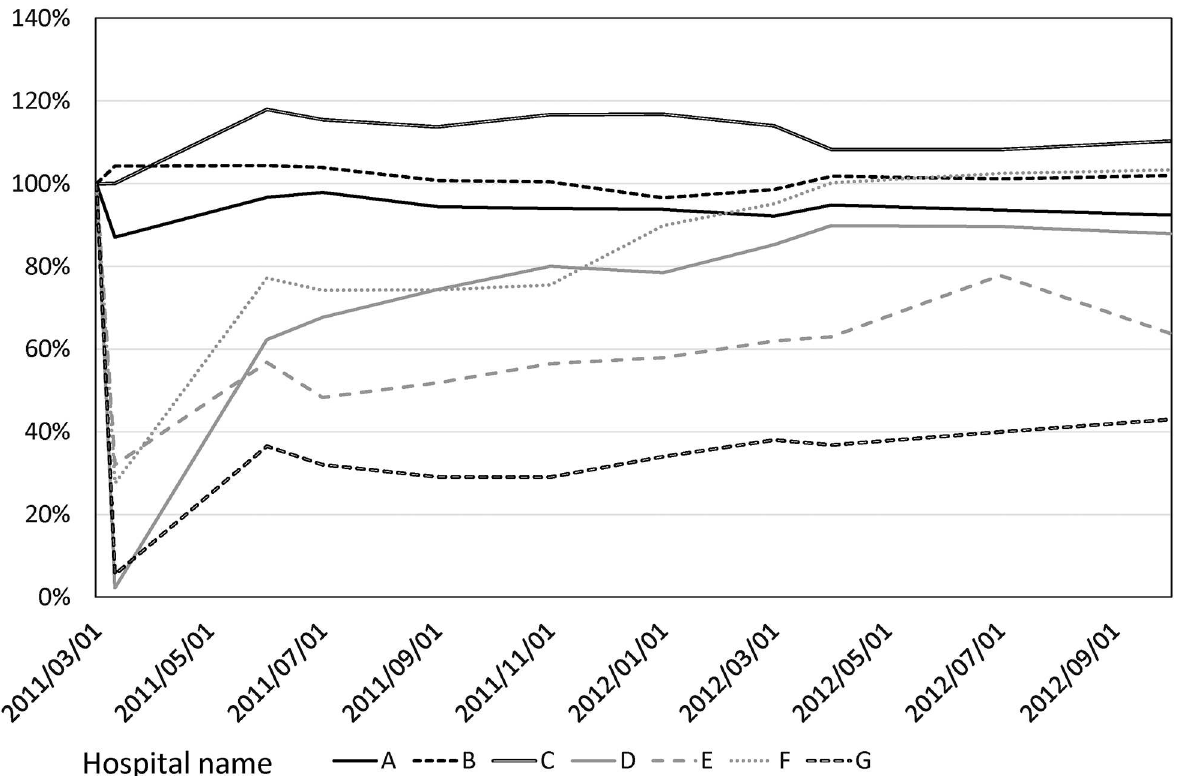
Fig 4. The % change in the number of hospital staff membersat each hospital within 18 months after the triple